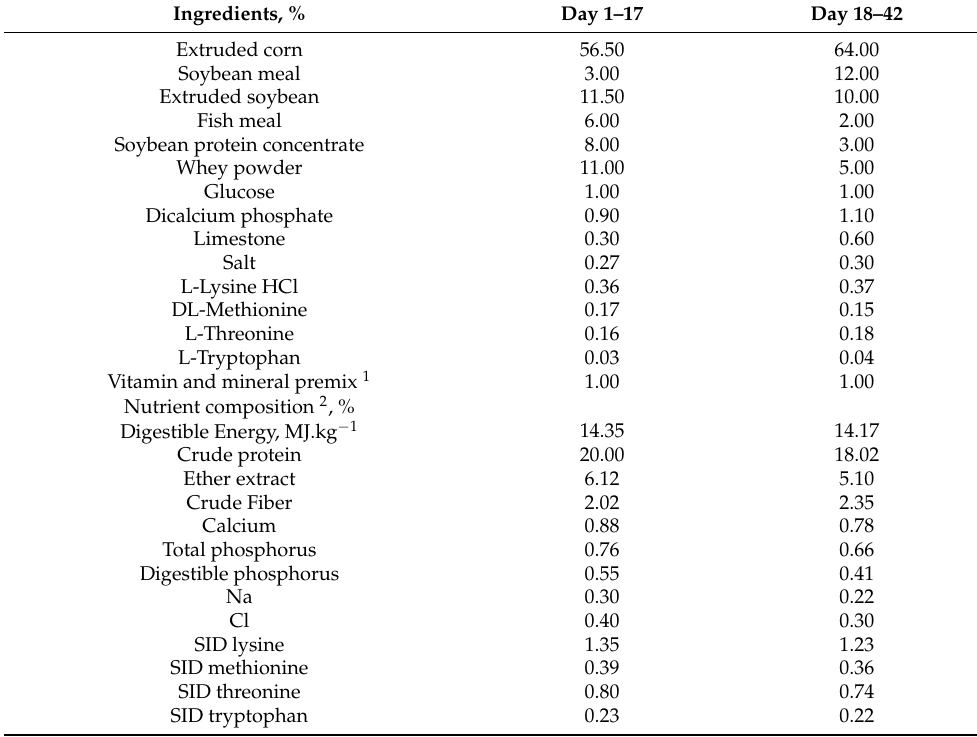
Table 1. Ingredients and chemical compositions of the basal diets (as-fed basis). Ingredients,